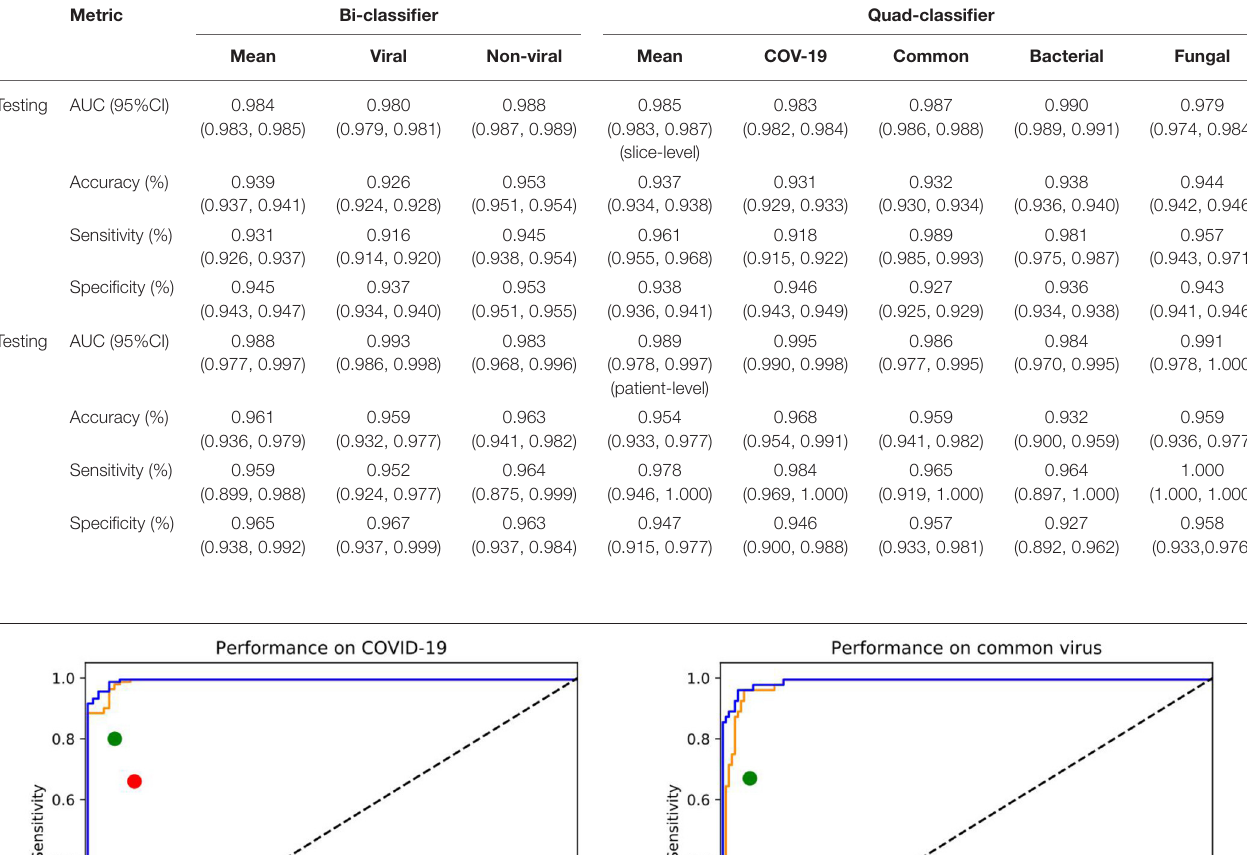
TABLE 2 | The performance of the DL system in making multi-pathogenic types classification based on the CT cohort.